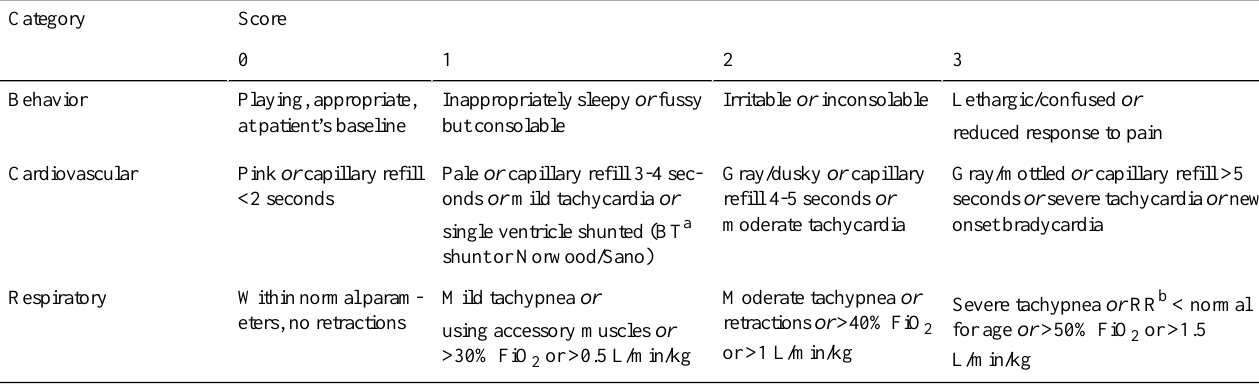
Table 1. Modified Pediatric Early Warning Score (PEWS). ScoreCategory baselineBehavior secondsCardiovascular